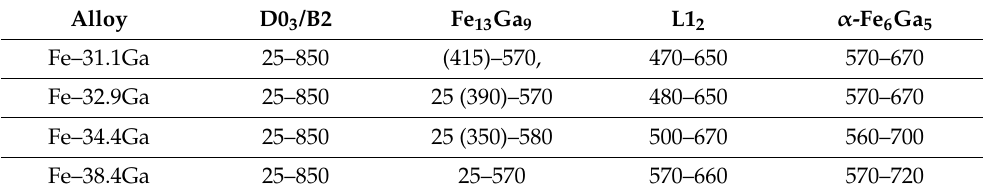
Table 6. Temperature ranges of the existence of individual phases in Fe–Ga alloys during heating up to 850 ◦ C. The temperature of the Fe 13 Ga 9 volume fraction jump is given in parentheses. Alloy D0 3 /B2 Fe 13 Ga 9 L1